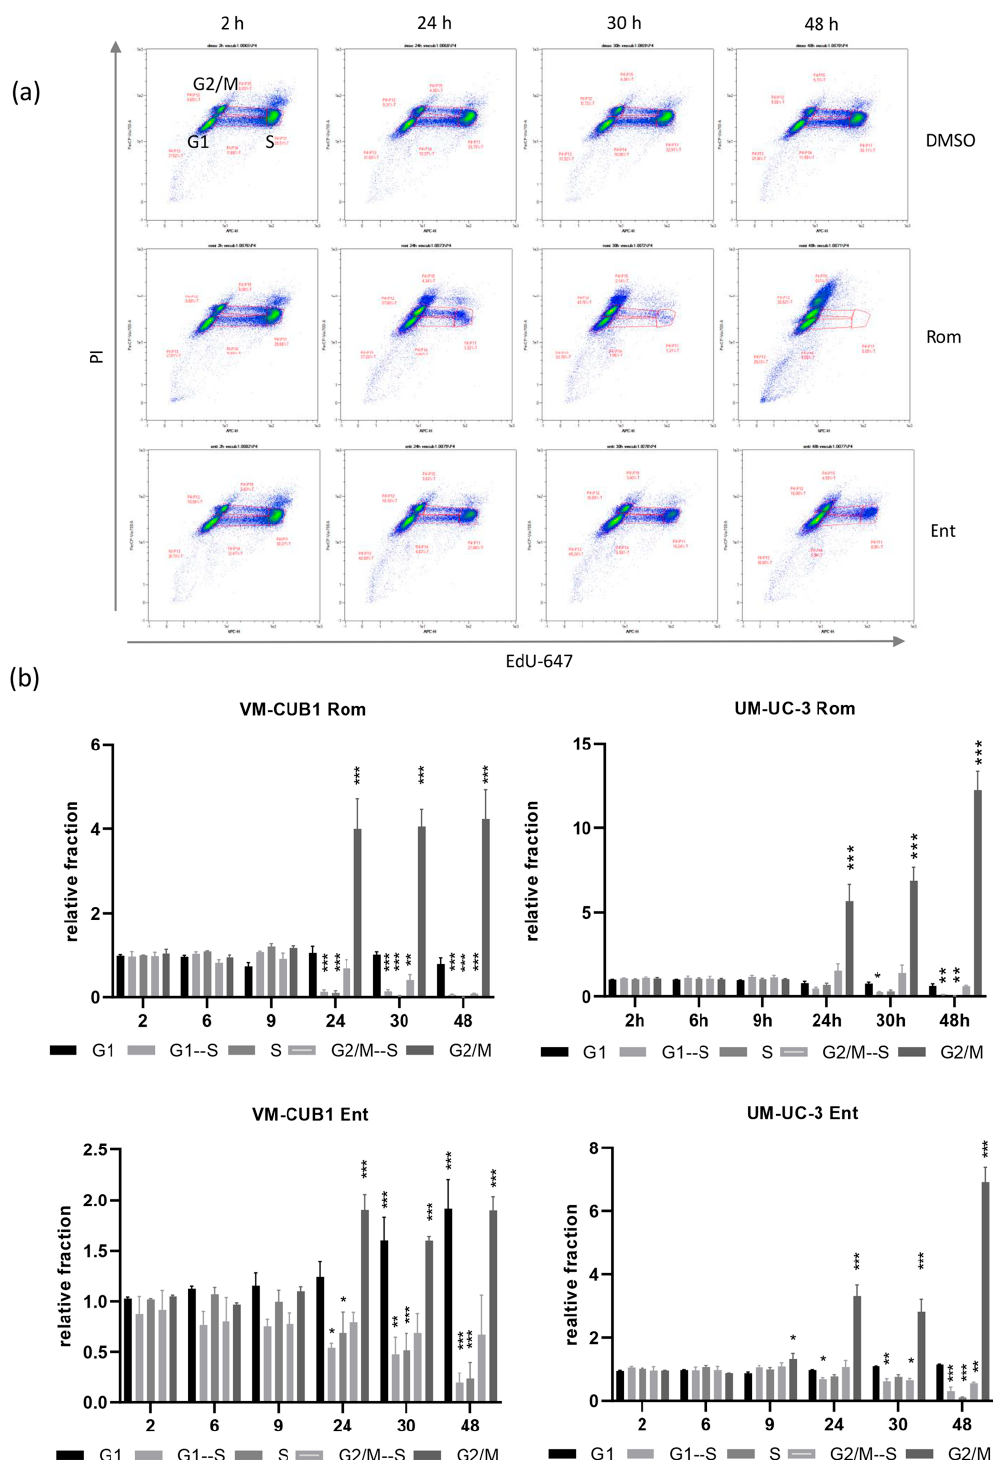
Figure 5. EdU label experiment with UCC after treatment with class I-specific HDACi. ( a ) Raw data plots for VM-CUB1 cells displaying Alexa-647 labeled EdU and PI after indicated treatments and time points. Different cell populations reflecting EdU-labeled or unlabeled cells are displayed in respective cell cycle phases. Example raw data of one representative experiment is visualized. ( b ) The means for percentages of cells in cell populations over time (indicated in hours) of three independent experiments were summarized as bar graphs. Results were normalized to DSMO control. *** p ≤ 0.001, ** p ≤ 0.01, * p ≤ 0.05.